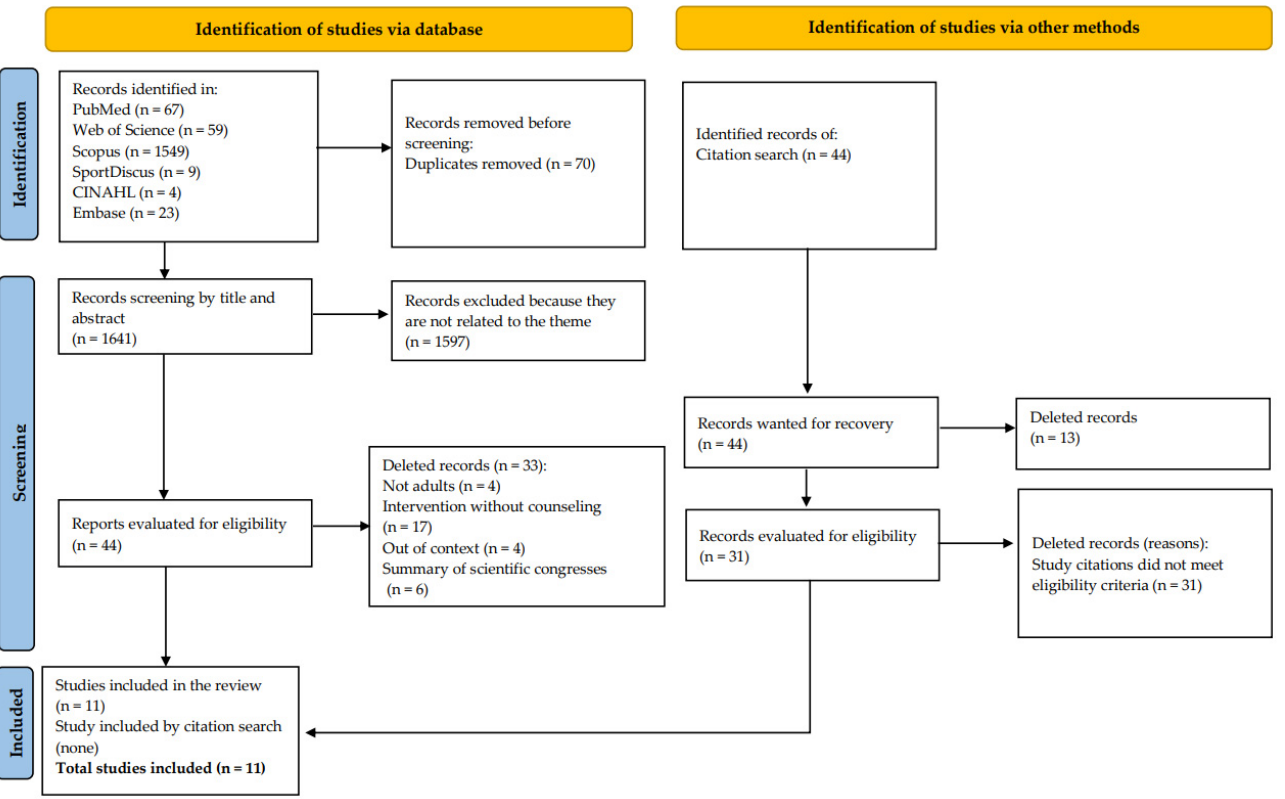
Figure 1. Flowchart of the studies selected via the database and via other methods.